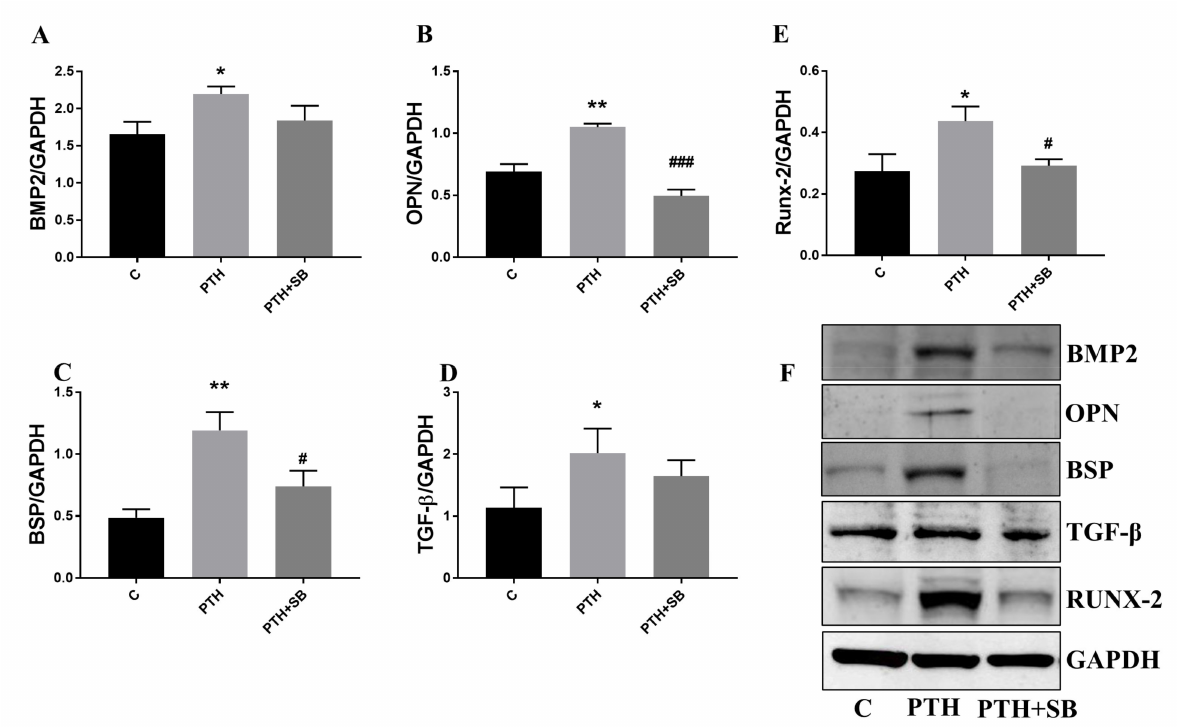
Figure 6. Protein expression of osteogenic molecules expressed by VEC exposed to PTH. ( A – E ) Quantification of protein expression of BMP-2, OPN, BSP, TGF- β 1 and Runx-2 in VEC as determined by western blot. ( F ) Representative western blot images for investigated molecules are presented. n = 3, * p < 0.05, ** p < 0.01 (control VEC vs. VEC exposed to PTH for 7 days); # p < 0.05, ### p < 0.001 (PTH+SB vs. PTH).